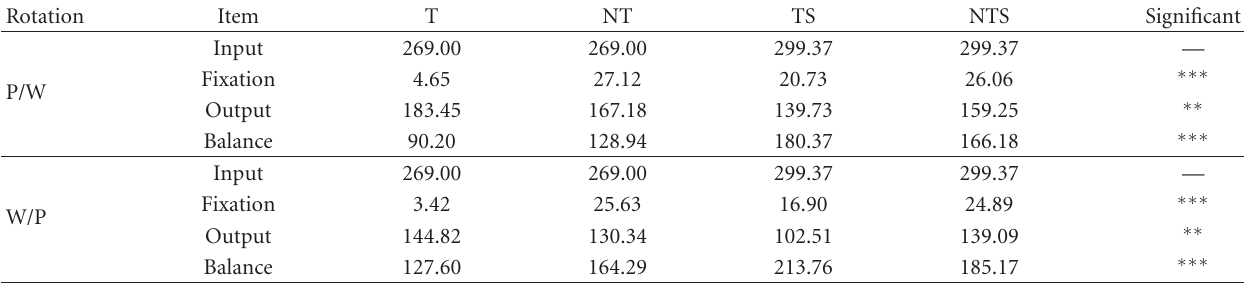
Table 5: Nitrogen balance under di ff erent treatments over 4 years (kgNha − 1 ).